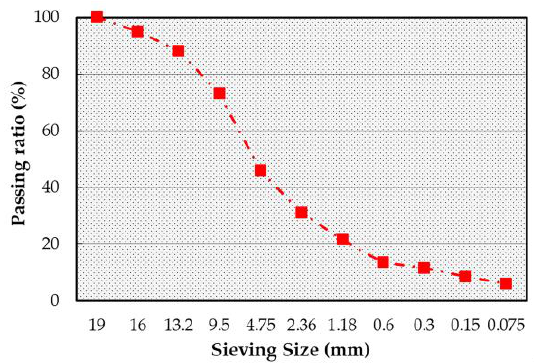
Figure 1. Gradation of AC16.